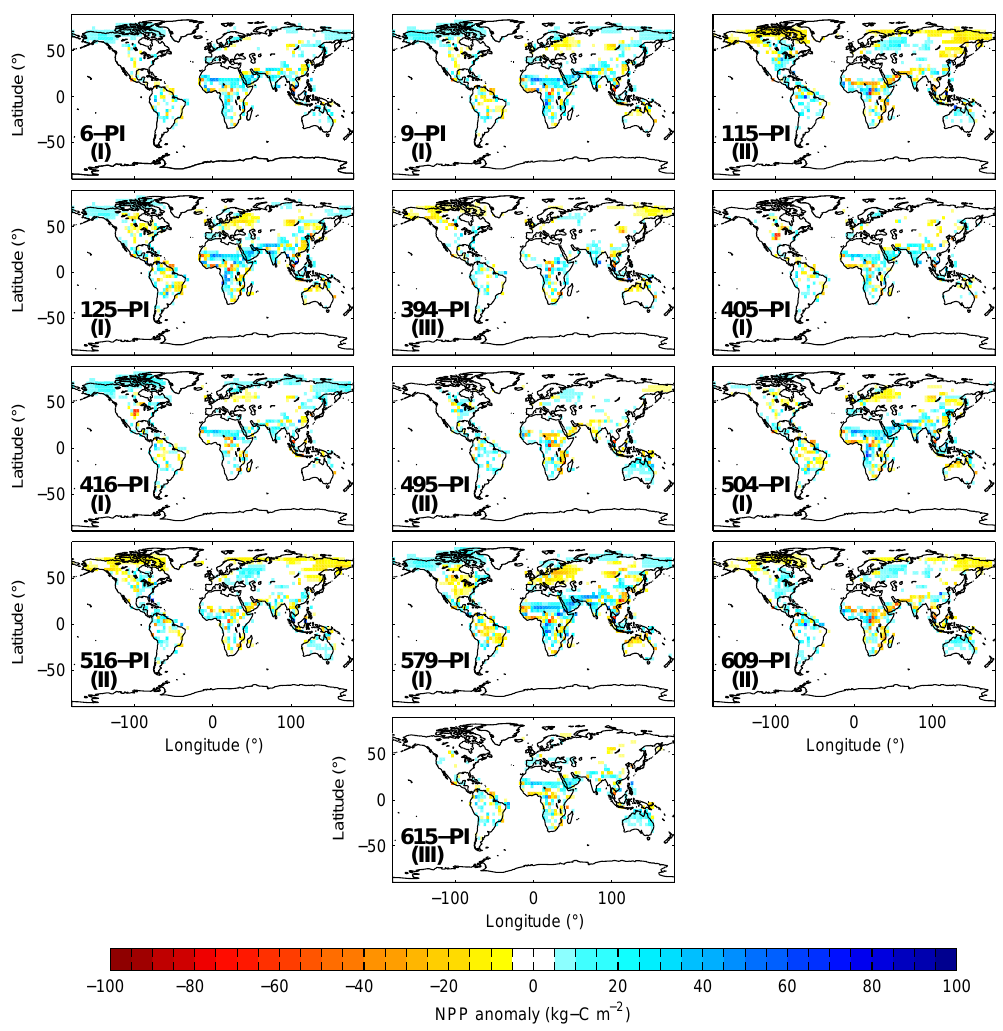
Figure 6. As in Fig. 3, but for annual net primary production.